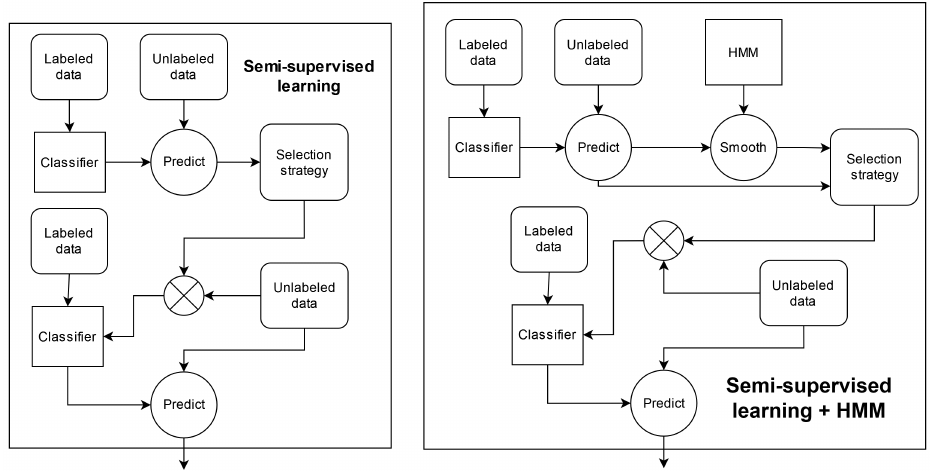
Figure 2. Diagrams for the general semi-supervised learning approach used in the 2020 pipeline ( left ) and the semi-supervised learning approach that combines HMM predictions in the selection strategy ( right ). The second approach was used in the 2019 pipeline